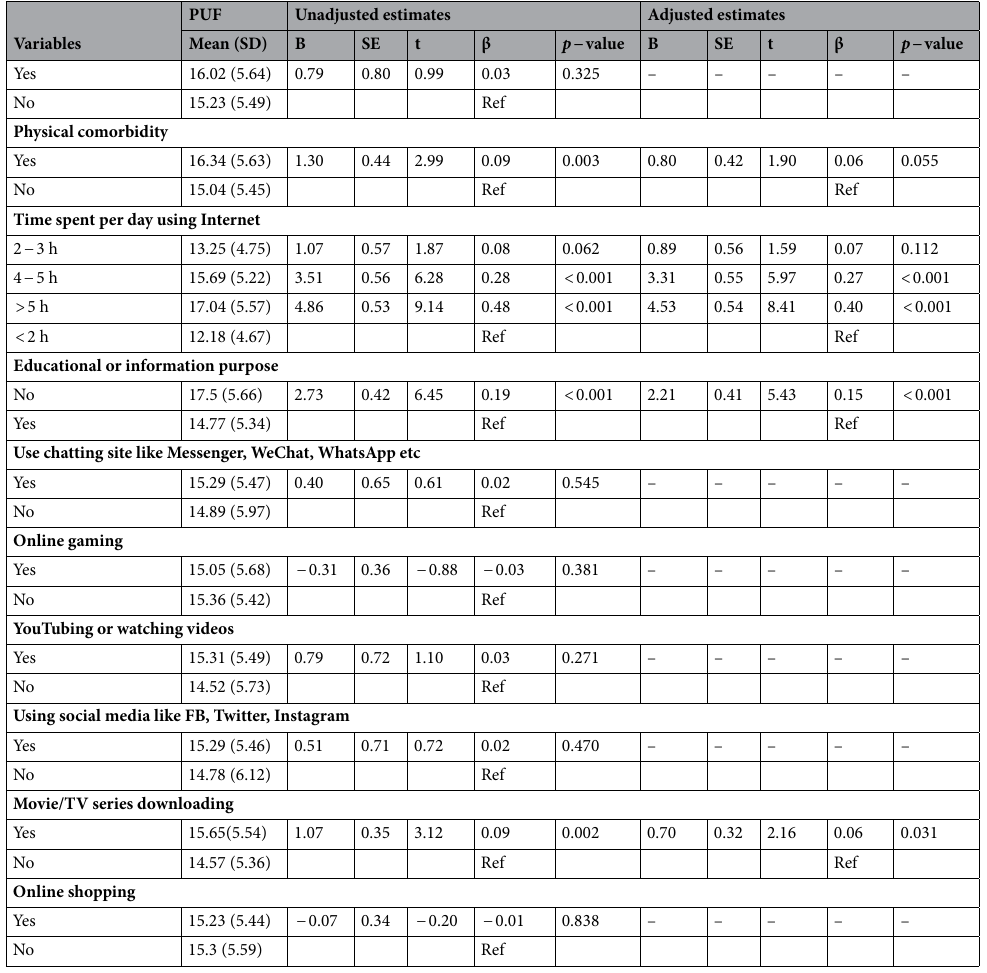
Table 2. Distribution of variables and regression analysis for PUF. SD Standard deviations; B unstandardized regression coefficient; SE Standard error; β standardized regression